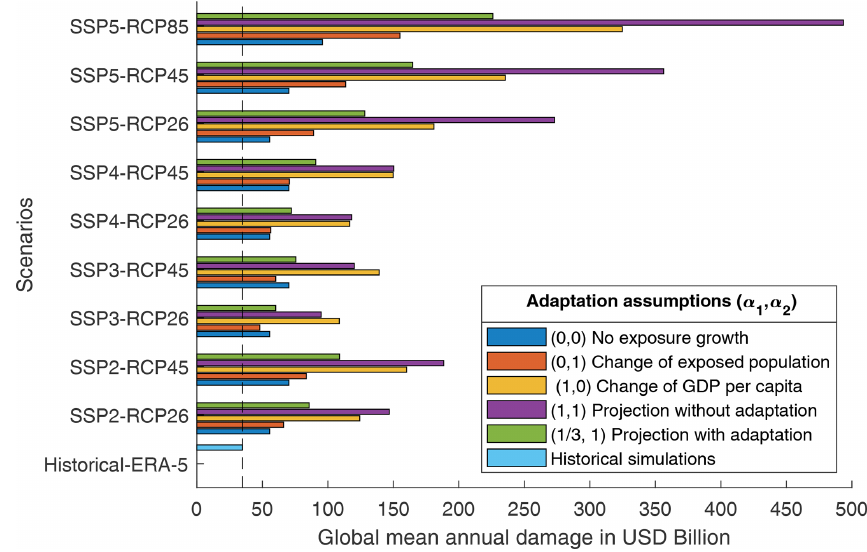
Figure 24. Expected value of global annual damage (in USD billion) in different SSP–RCP and exposure projection hypothesis configura- tions. The vertical dotted line corresponds to historical simulations with ERA5 data.